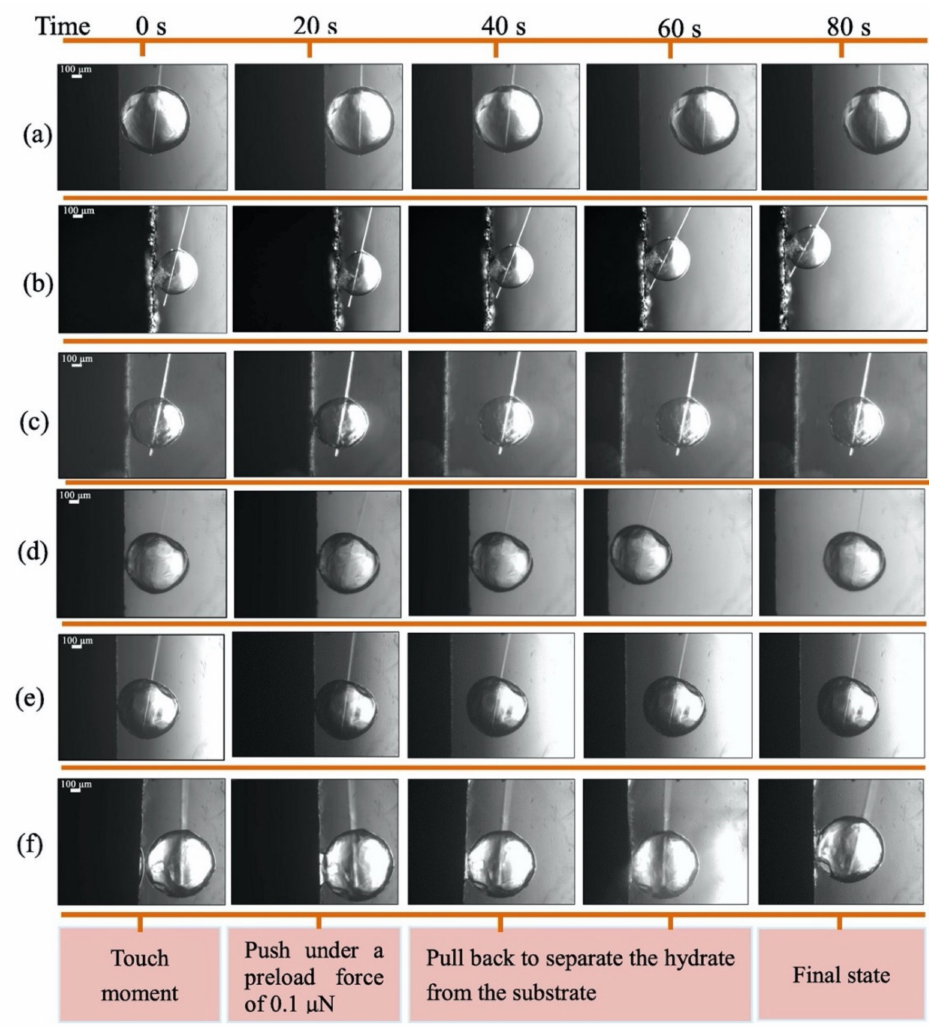
Figure 3. The images obtained at 20-s intervals from the touch moment during the adhesion measurement for different treated substrates: ( a ) X80; ( b ) Coating without surface modification; ( c ) CeO2/pDA@X80 coating; ( d ) X80 after sand abrasion; ( e ) CeO2/pDA@X80 coating after sand abrasion; ( f ) X80 with a water drop deposited on the surface. Reprinted with permission from ref. [54]. © 2021